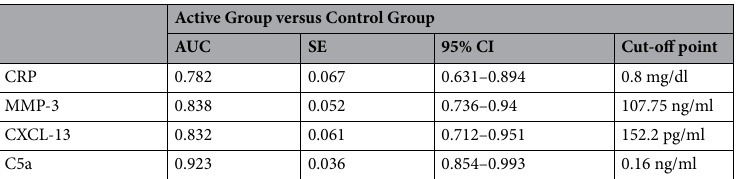
Table 3. Receiver operating characteristic curve analysis for C5a, CXCL-13, MMP-3 and CRP comparing the Active Group with the Control Group. AUC, area under the curve; CRP, C-reactive protein; CXCL-13, chemokine CXC ligand 13; C5a, complement component C5a; MMP-3, metalloproteinase 3; SE, standard